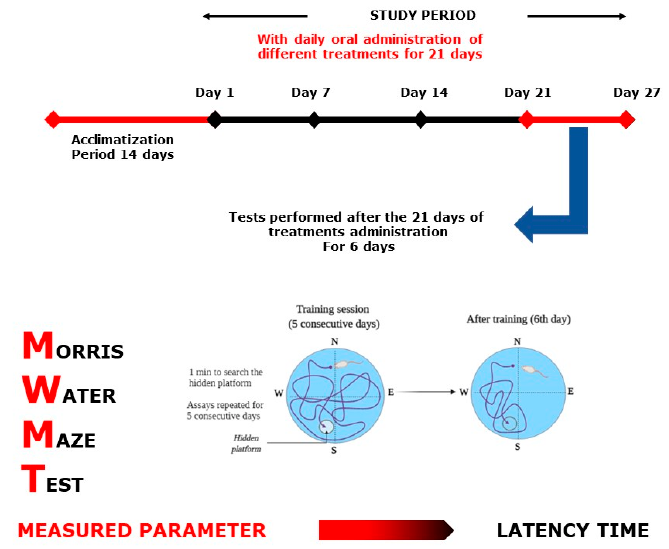
Figure 13. Morris Water Maze Test scheme.